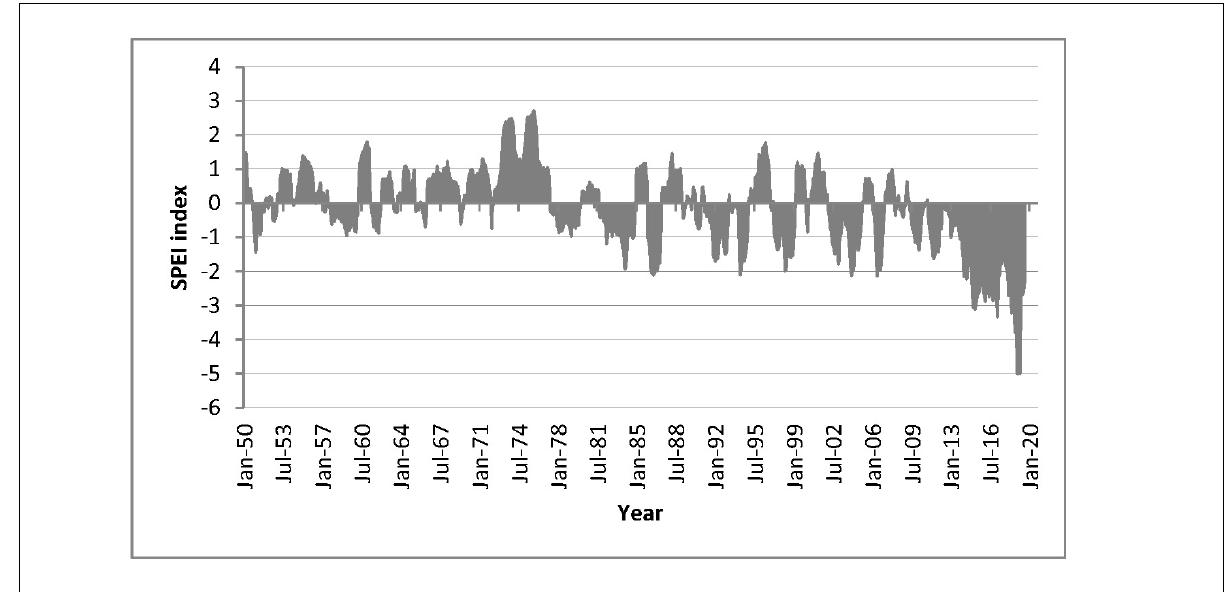
Figure 2: Standardised Precipitation and Evaporation Index (SPEI) for the Van Wyksvlei area from January 1950 to August 2020.